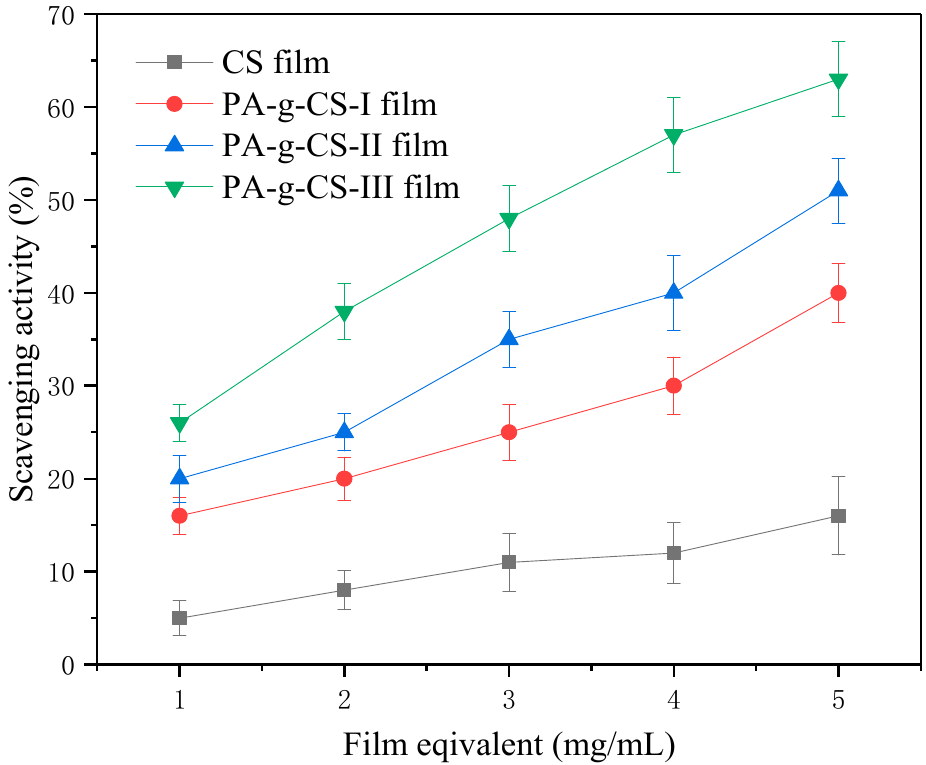
Figure 7. DPPH radical scavenging activity of the CS and PA-g-CS films.